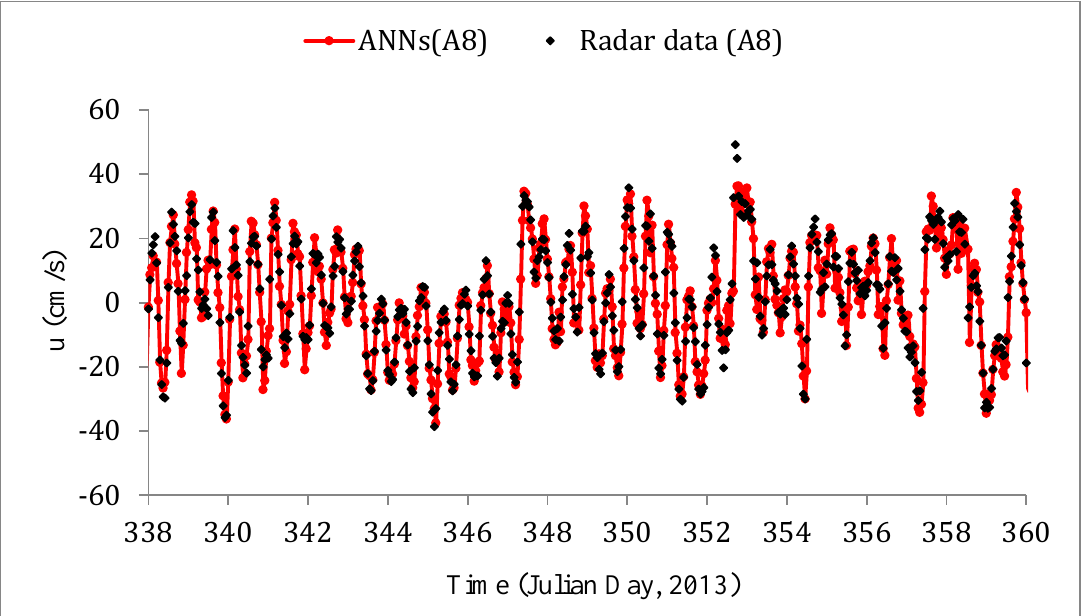
Figure 8. Forecasts of u velocity component at A8 (Model U8, 1 h forecast window).